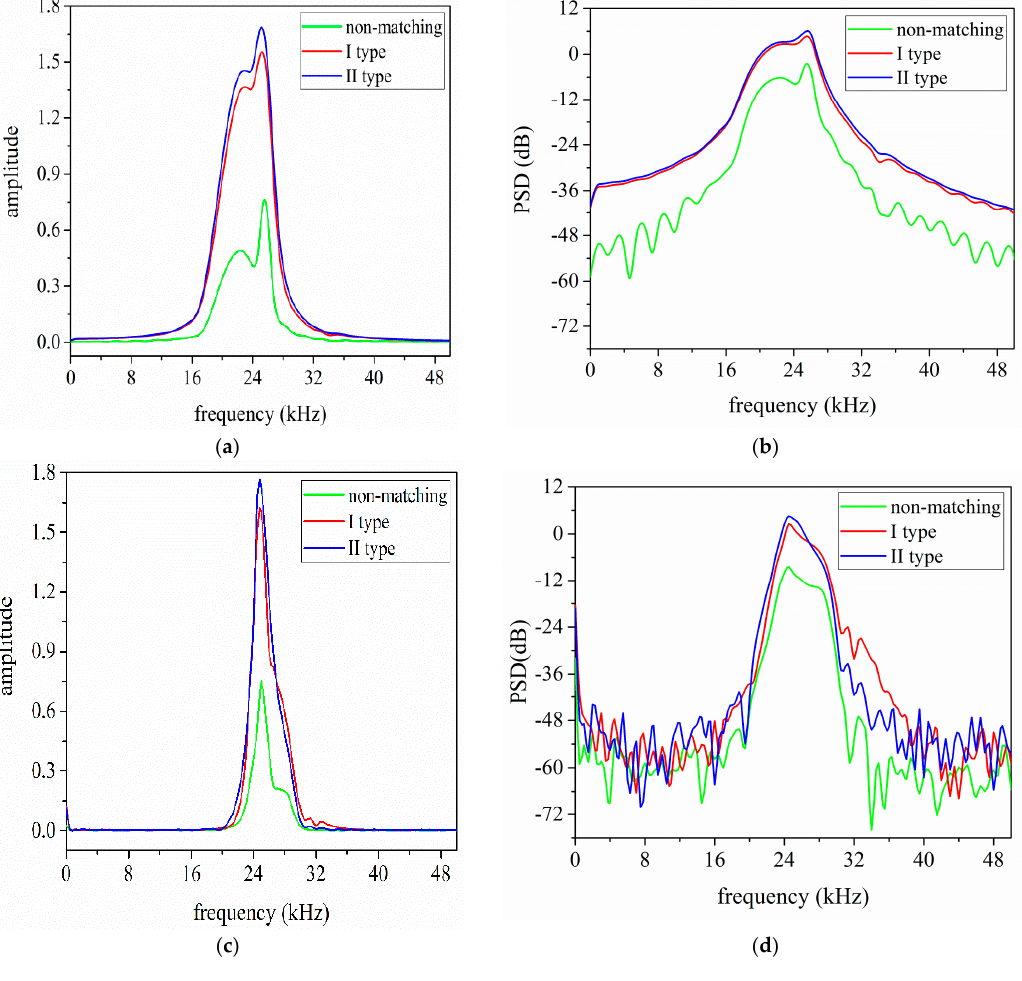
Figure 14. The frequency spectrum analysis results of the received voltage signals, ( a , b ) the simulated results; and, ( c , d ) the measured results.